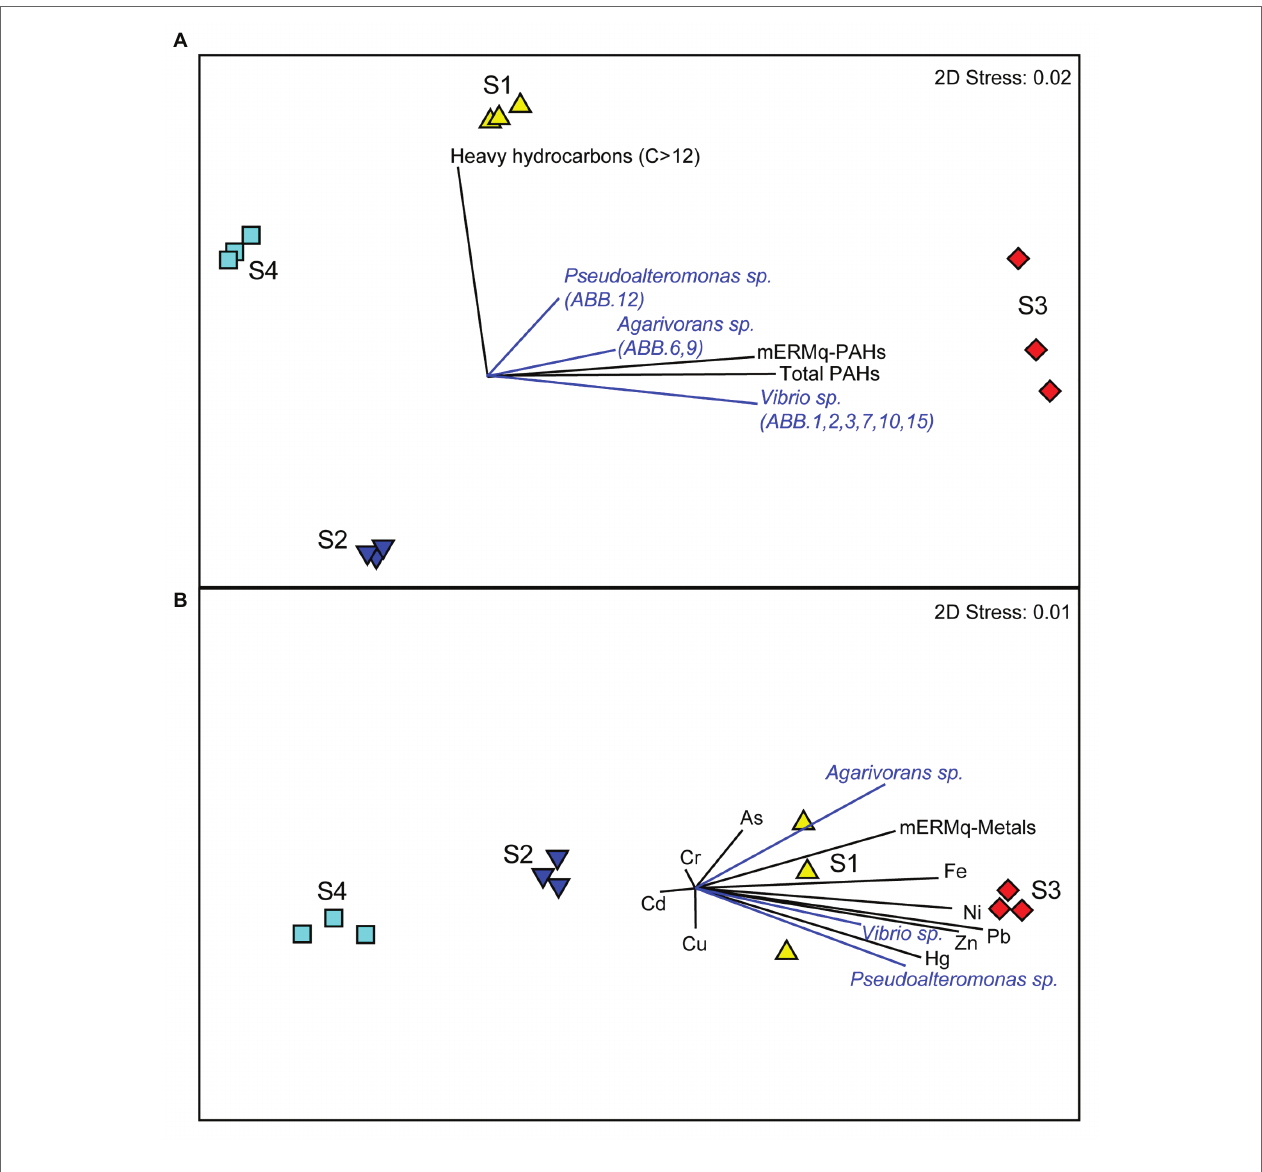
FIGURE 7 | (A,B) Relationship between the organic and inorganic contaminations and the distribution of Vibrio sp., Agarivorans sp. and Pseudoalteromonas sp. in the investigated benthic sites of the Bagnoli-Coroglio area. (A) The MDS plot shows the distribution of the sediment samples based on aliphatic hydrocarbon and polycyclic aromatic hydrocarbon (PAH) contamination levels, with black vectors indicating higher values of hydrocarbon contamination and of the resulting mEMq values for PAHs at sites S1 and S3, and blue vectors indicating the higher contribution of the sequences affiliated to Vibrio sp., Agarivorans sp., and Pseudoalteromonas sp. isolates to the overall prokaryotic assemblage. (B) The MDS plot shows the distribution of the sediment samples based on HMs contamination levels, with black vectors indicating higher values of the different HMs and of the resulting mEMq values for HMs at sites S1 and S3, and blue vectors indicating the higher contribution of the sequences affiliated to Vibrio sp., Agarivorans sp., and Pseudoalteromonas sp., isolates to the overall prokaryotic